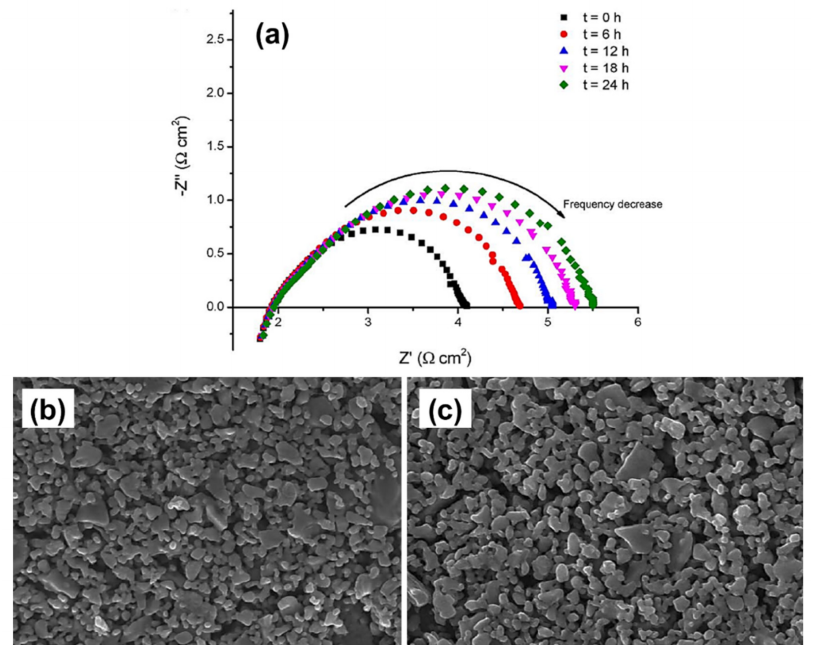
Figure 7. ( a ) EIS measurement of the LSCF cathode at 750 ◦ C, XPS analysis, and SEM analysis ( b ) before and ( c ) after heat treatment time under open-circuit voltage [36] ( © The Electrochemical Society. Reproduced by permission of IOP Publishing. All rights